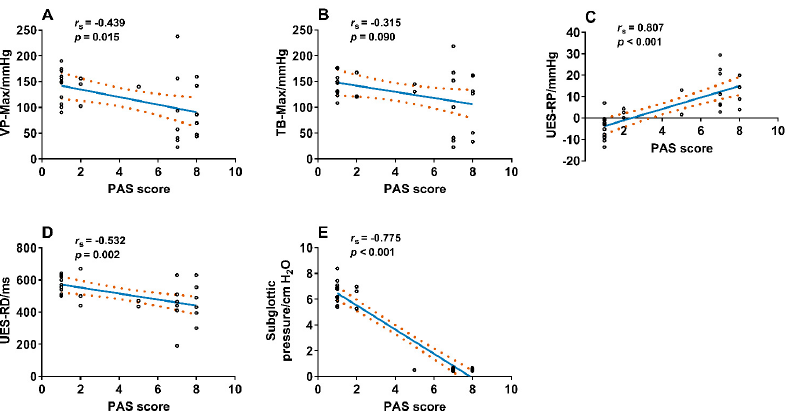
Figure 4. Correlation between VP–Max, TB–Max, UES–RP, UES–RD, subglottic pressure, and PAS score in the patient group. VP–Max ( A ), r s = − 0.439, p = 0.015, UES–RD ( D ), r s = − 0.532; p = 0.002, and subglottic pressure ( E ), r s = − 0.775; p < 0.001 were negatively correlated with PAS score; UES–RP ( C ), r s = 0.807 , p < 0.001 was positively correlated with PAS score, and the correlation between TB–Max and PAS score was not significant ( B ), r s = − 0.315, p = 0.090. Note: VP–Max, velopharynx maximal pressure; TB–Max, tongue base maximal pressure; UES–RP, UES residual pressure; UES–RD, UES relaxation duration; PAS score, penetration–aspiration scale score.